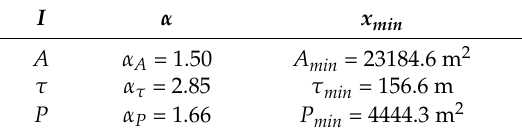
Table 2. Parameter estimation of power law